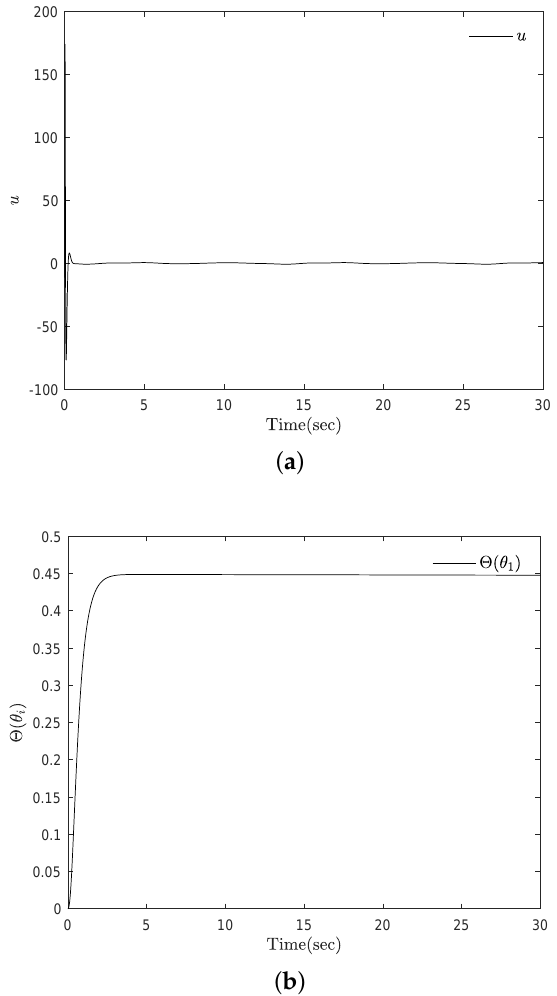
Figure 5. The control input and the Nussbaum function’s output for Example 2: ( a ) u ; ( b ) Θ ( θ 1 )